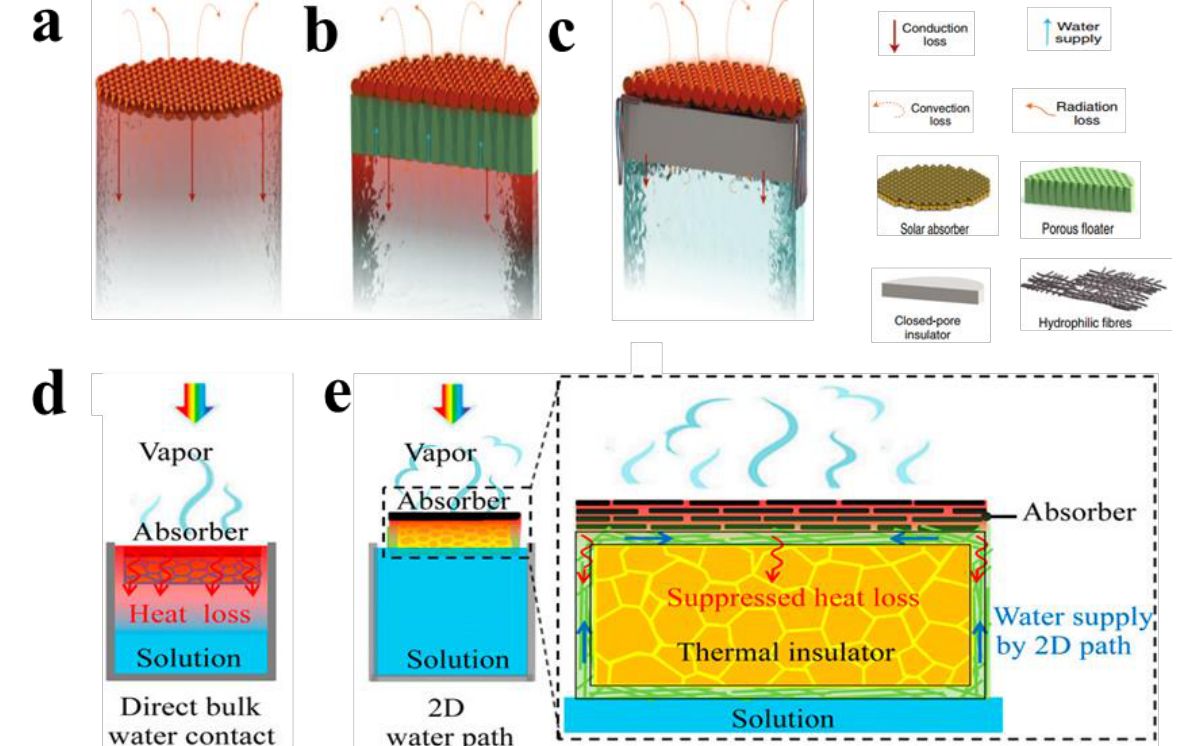
Figure 4: Thermal management design for solar steam generation system: (a) single-layered and (b, c) double-layered floating evaporation structure [35]; (d) conventional evaporation structure; (e) thermal insulator devices with water supply